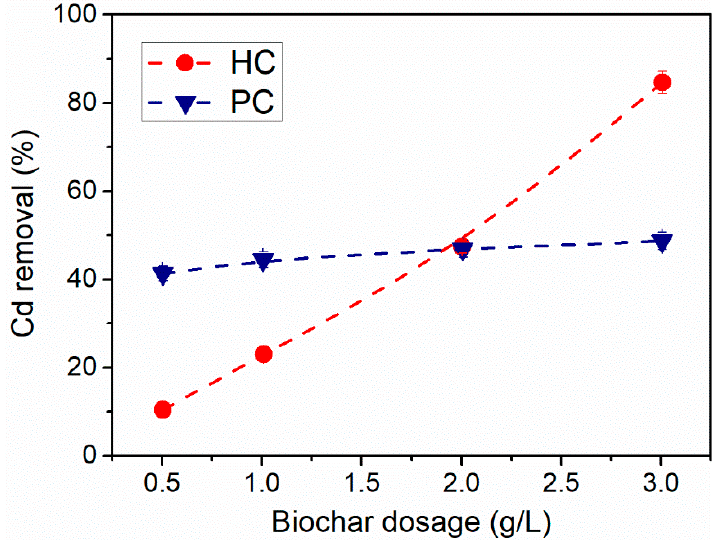
Figure 6. Effect of biochar dosage effect on cadmium removal by HC and PC. ([Cd] o = 0.5 mg/L, initial Cd solution pH = 4.0, adsorption time = 24